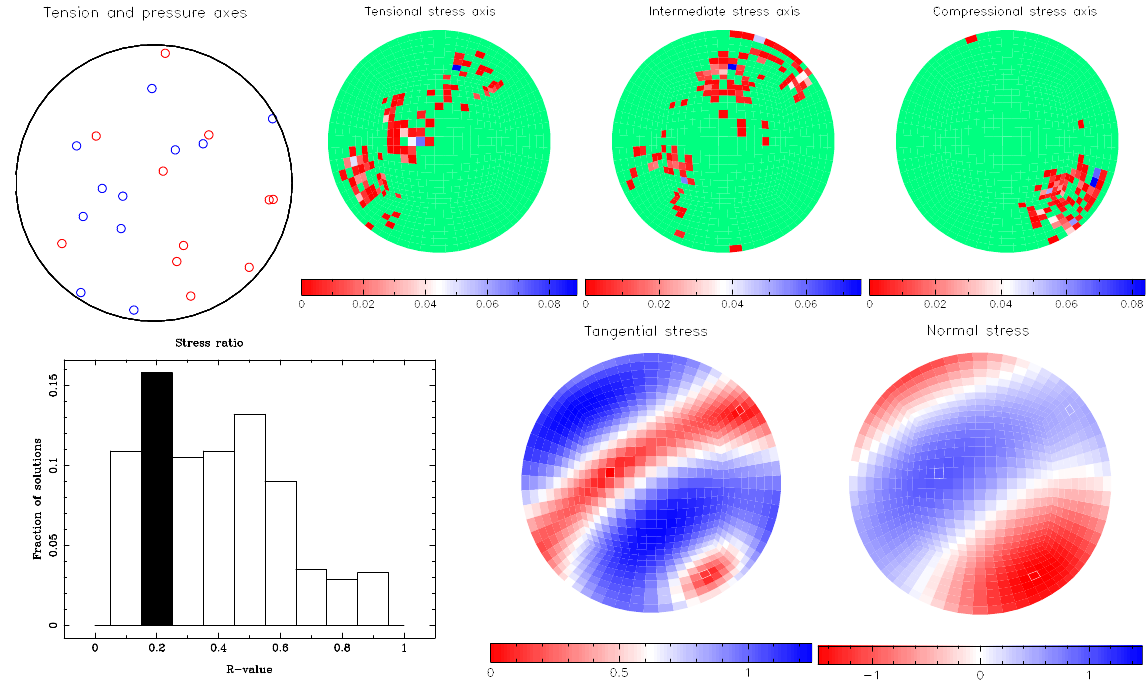
Fig. A8. Results of stress inversion for cluster of intermediate-depth earthquakes beneath the Cyclades. Explanation of subfigures is as in Fig. 5.